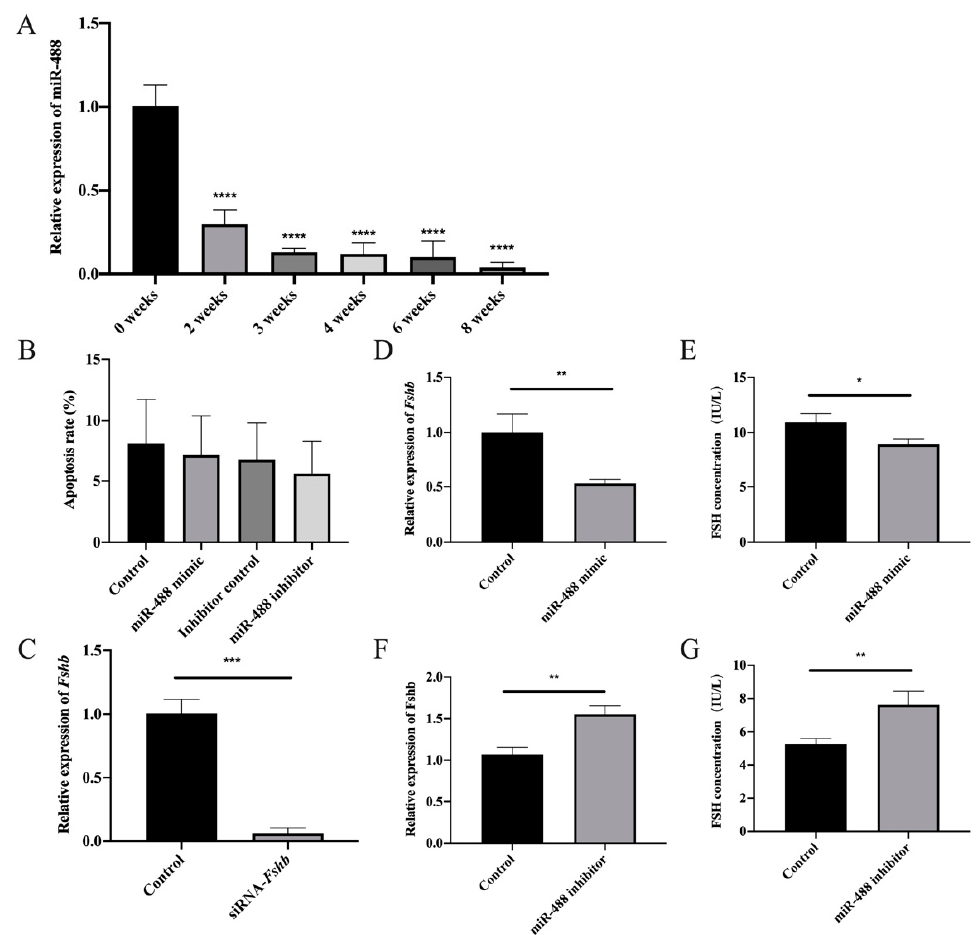
Figure 4. Regulation of FSH synthesis by differentially expressed miR-488 in rat anterior adenohy- pophyseal cells. ( A ) The expression of miR-488 in the pituitary glands of rats aged 0, 2, 3, 4, 6, and 8 weeks. ( B ) The apoptosis rate of rat anterior adenohypophyseal cells after transfection. ( C ) The relative expression of Fsh β after transfection with siRNA. ( D – G ) The levels of Fsh β mRNA expression and FSH synthesis after the transfection of a miR-488 negative control sequence, mimic, and inhibitor into rat anterior adenohypophyseal cells for 24 h. All experiments were repeated at least three times. Data are presented as the means ± SD. p < 0.05 was considered significant, and the differences are marked with the symbol *. When p < 0.01, ** was used to show the significance of the difference. When p < 0.001, *** was used to show the significance of the difference. When p < 0.0001, **** was used to show the significance of the difference.